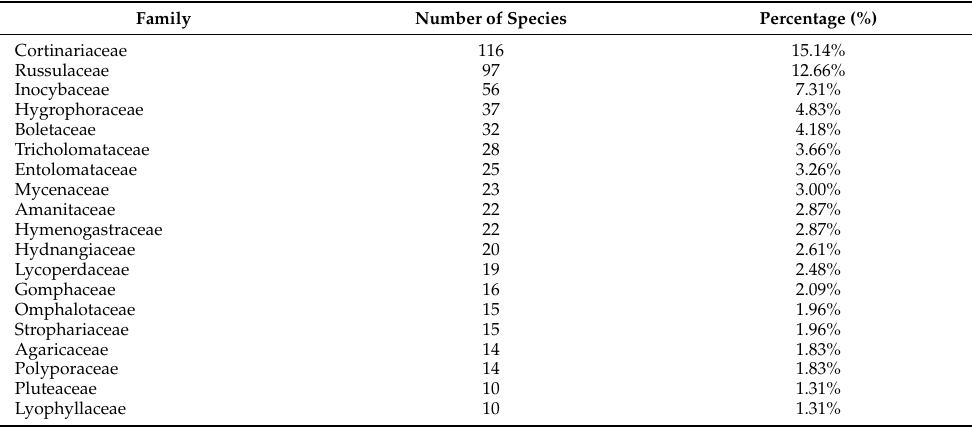
Table 2. Dominant families ( ≥ 10 species) of macrofungi in Shaluli